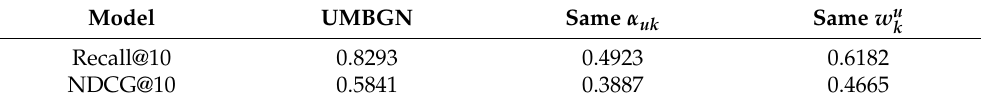
Table 3. Results of ablation experiments with multi-behavior weights on Online